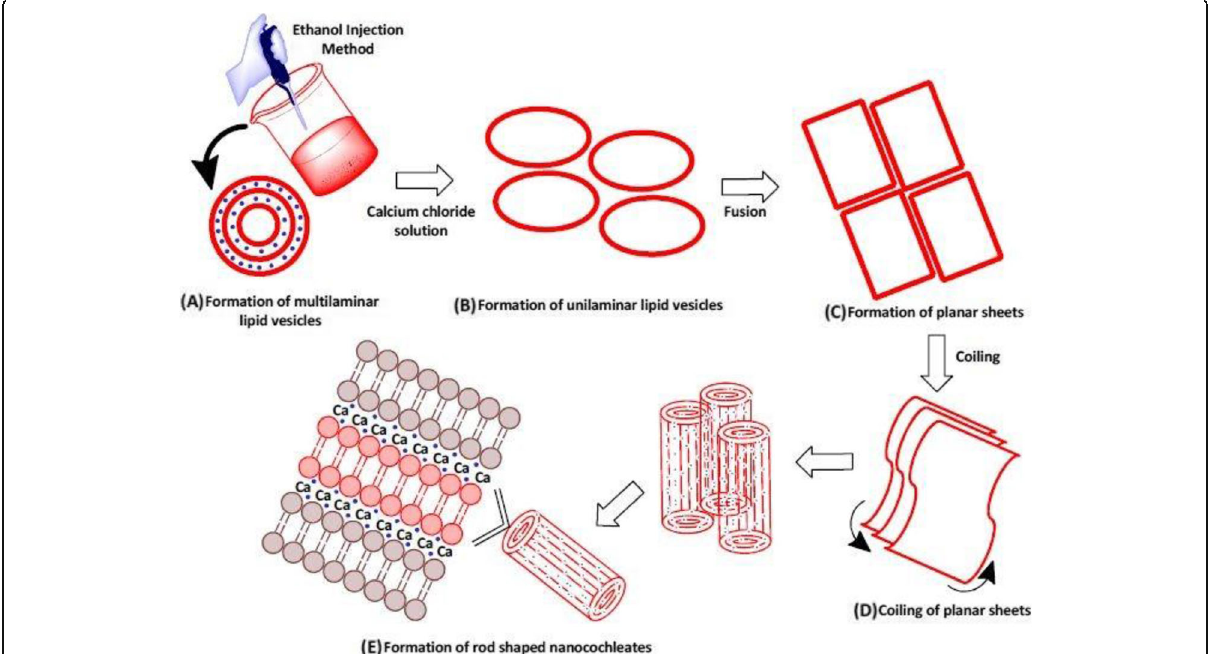
Fig. 1 Scheme for the synthesis of resveratrol loaded nanocochleates